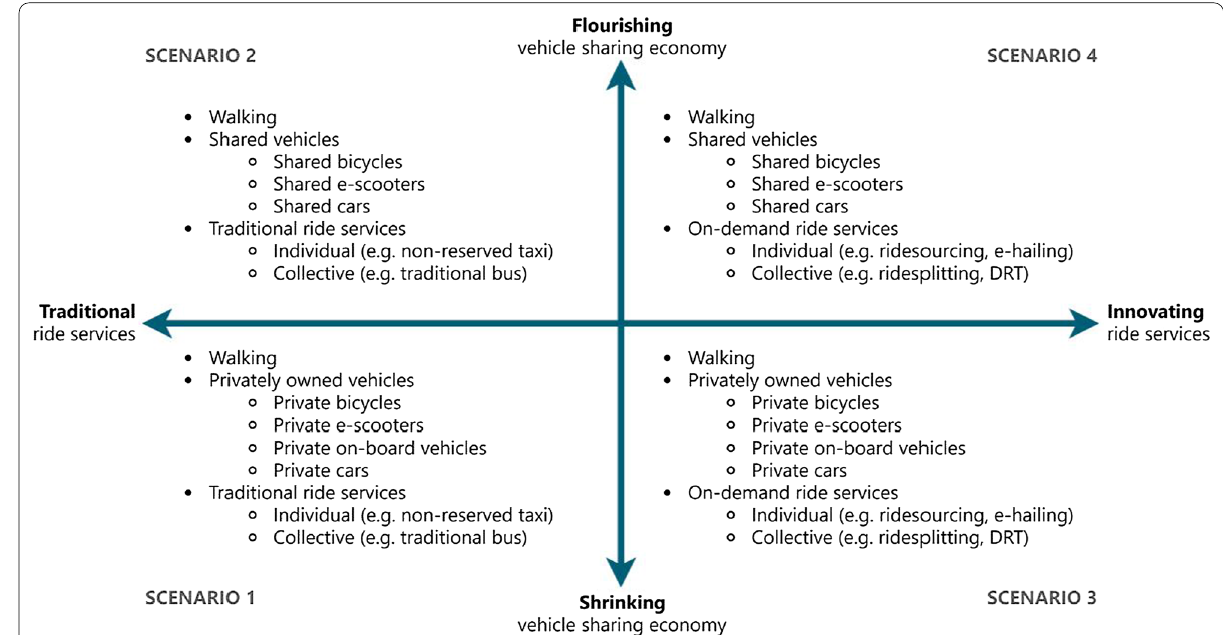
Fig. 3 Expected dominating means of first/last mile transport in each